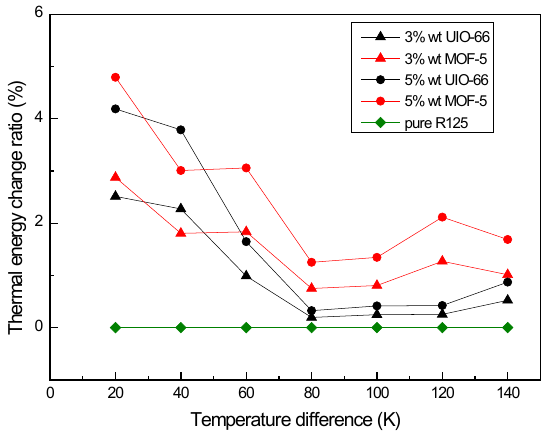
Figure 7: The enthalpy difference at different temperature difference (5 MPa).